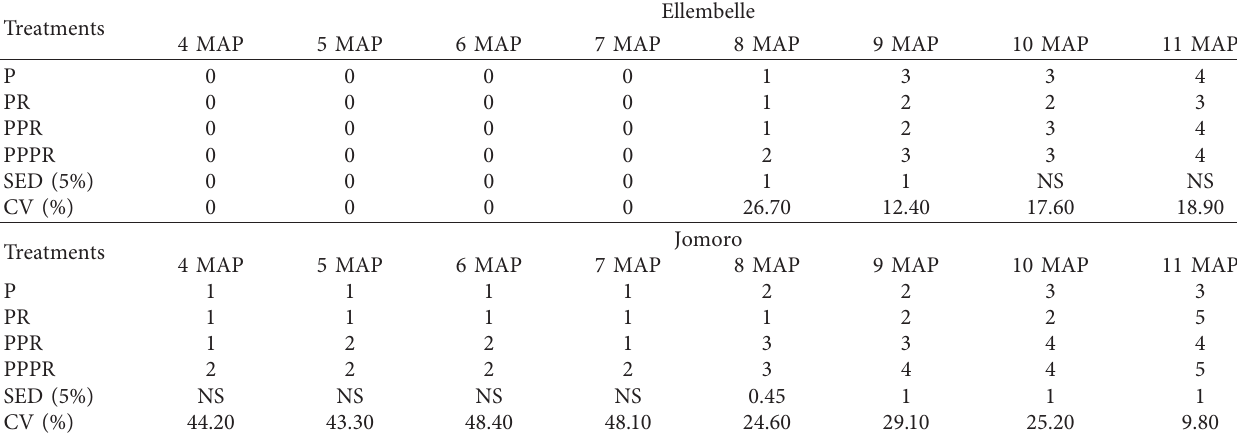
Table 9: Number of suckers of plantain under the different plantain densities at Ellembelle and Jomoro. Treatments